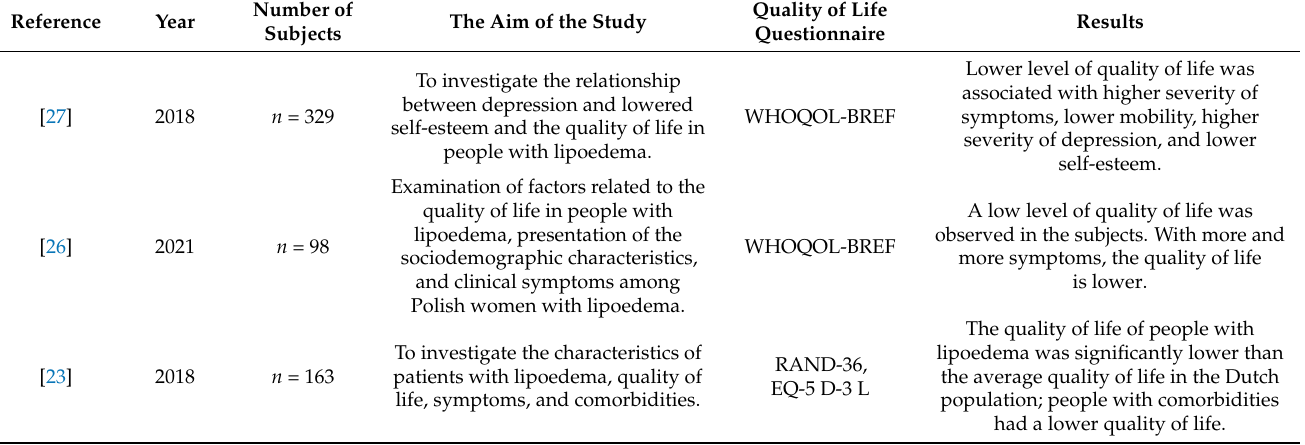
Table 4. Summary of studies assessing quality of life among people with